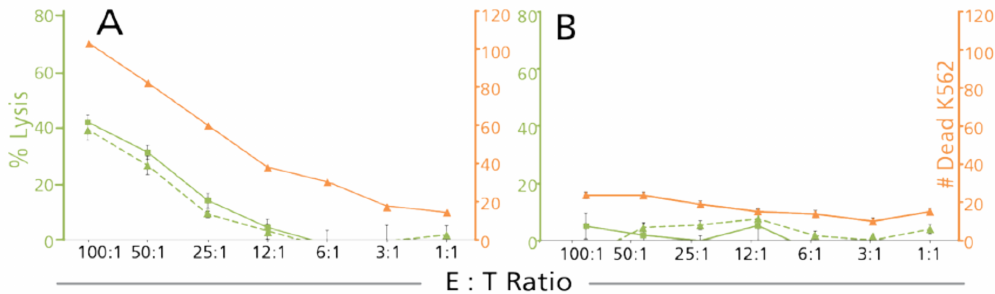
Figure 8. Concordant detection of killing by counting dead- and % reduction in numbers of live target cells. Sixty-four PBMC samples were tested in the Calcein TVA (green dashed lines referring to the green Y-axis on the left ), and the CFSE/PI TVA in parallel, whereby in the latter the dead target cell counts are represented by the orange lines (referring to the orange Y-axis on the right ), and the % reduction in live target cells (% CFSE lysis) by the solid green lines (referring to the green Y-axis on the left ). Representative results are shown for a PBMC donor whose cells did exert NK killing ( A ), and for a donor whose PBMC lacked cytolytic NK activity ( B